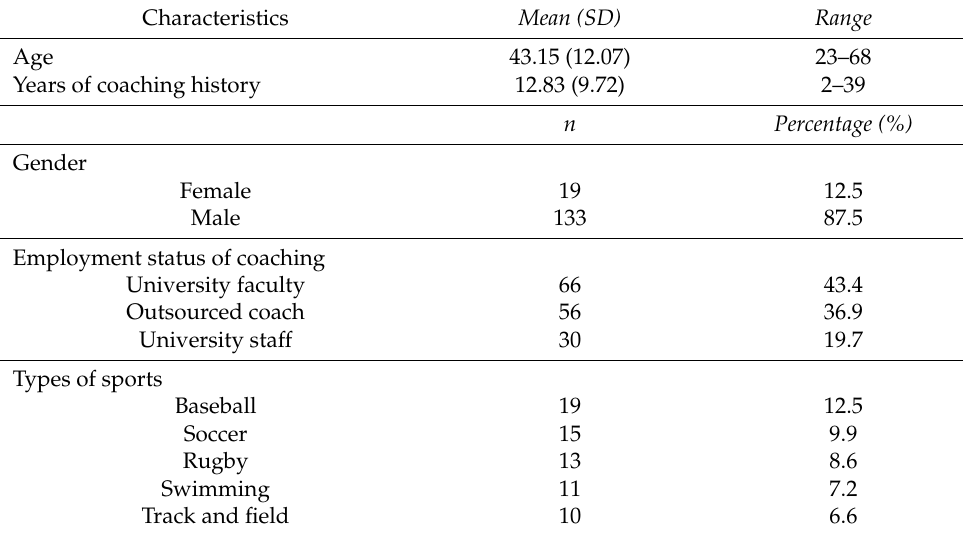
Table 1. Participant